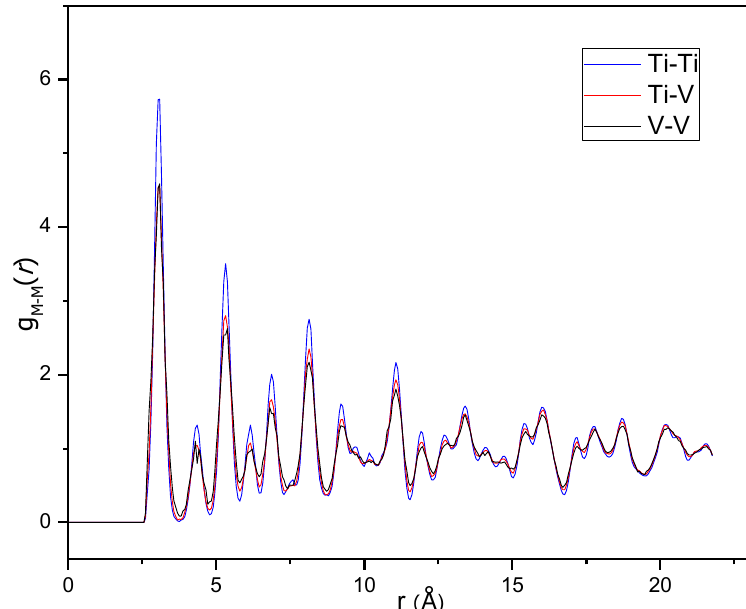
Figure 8. Partial pair distribution functions between non-Fe metals g Ti-Ti ( r ), g Ti-V ( r ) and g V-V ( r ) from an RMC model of Ti 0.63 V 0.27 Fe 0.10 D 1.73.